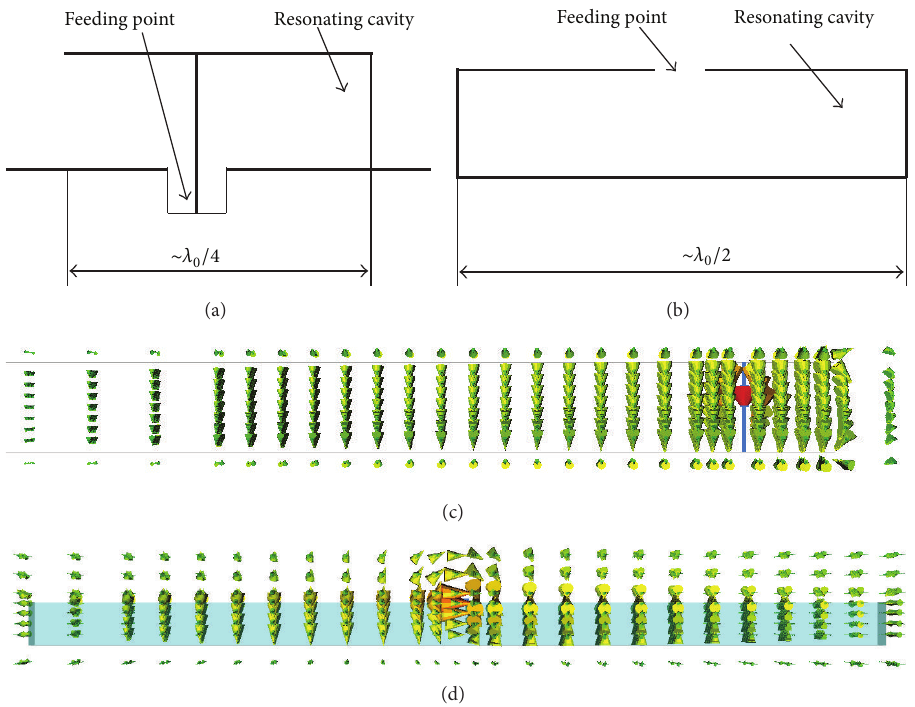
Figure 2: Cross section ((a) and (b)) and electric field distribution ((c) and (d)) of the standard shorted patch and coupled shorted patches, respectively.